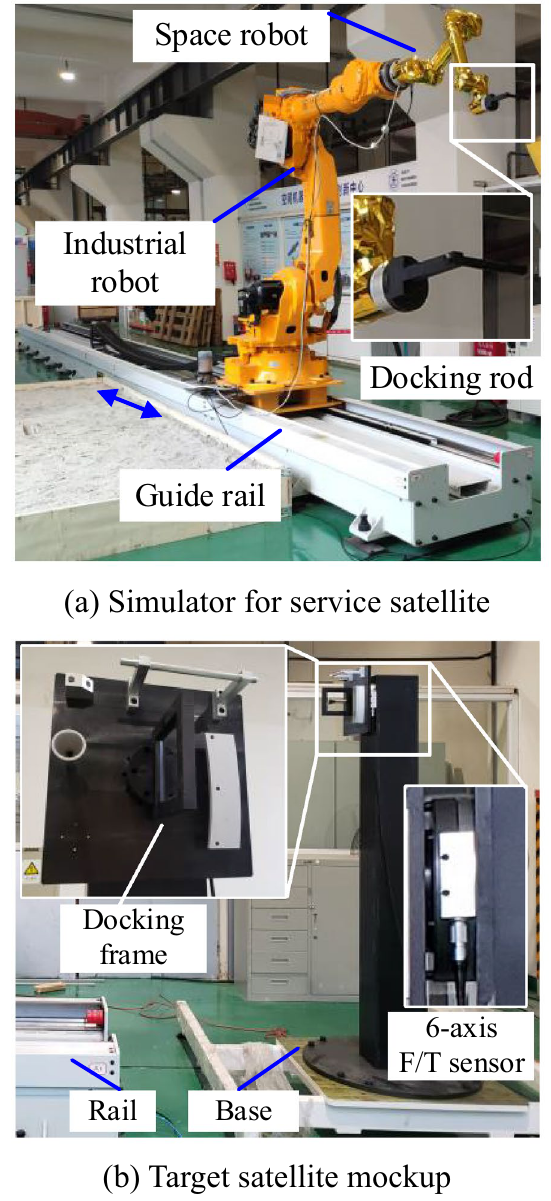
Figure 1 Prototype of the HIL simulation